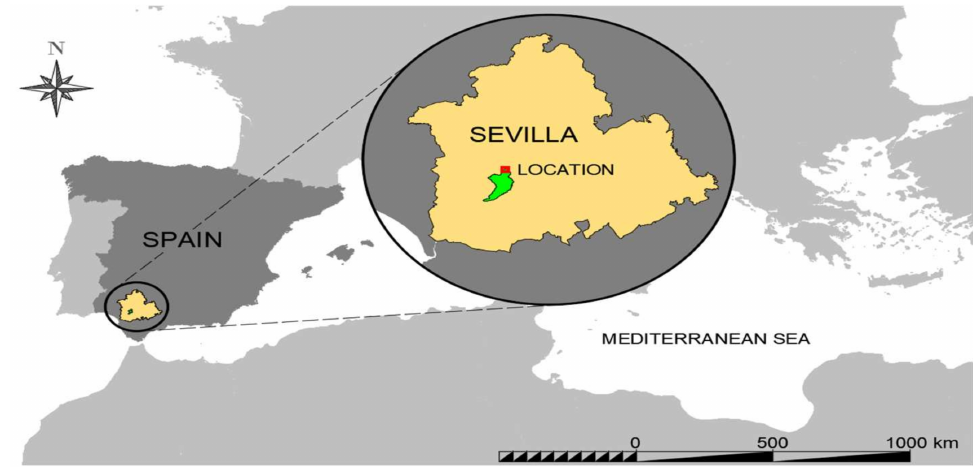
Figure 2. Location of the